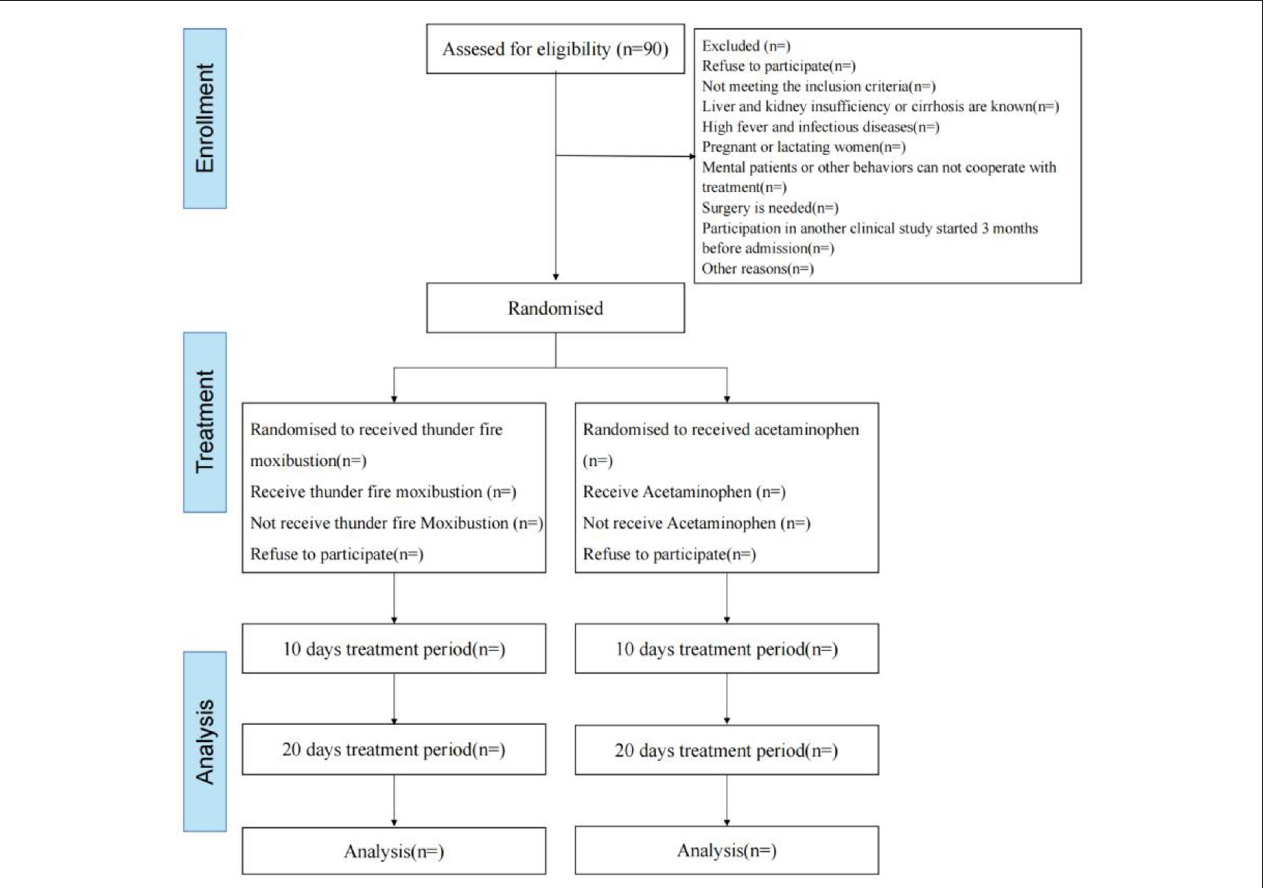
FIGURE 1 | Flow chart of the trial. A total of 90 participants will be randomized to the two groups. The study period will consist of the baseline, end of the 10-day intervention, and 20-day